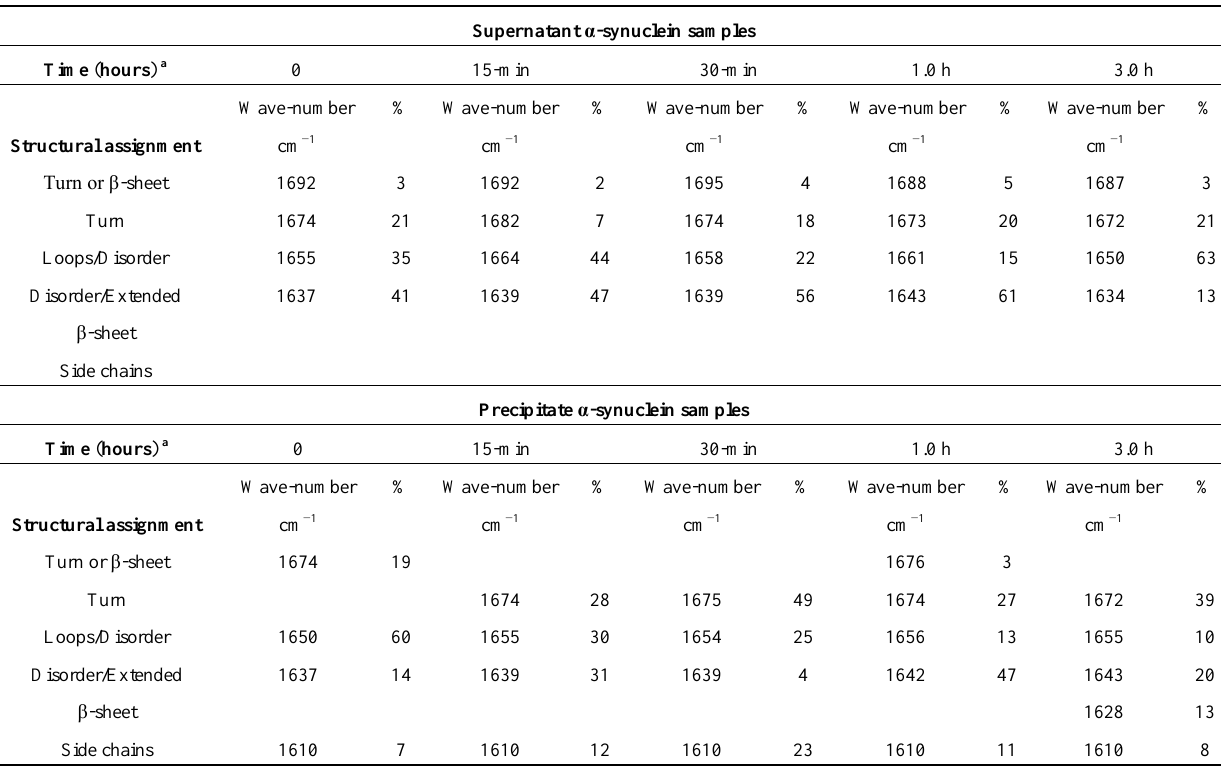
Table 2. ATR-FTIR evaluation of secondary structure content during the fibrillation process for human α-synuclein with rotenone introduced at selected time